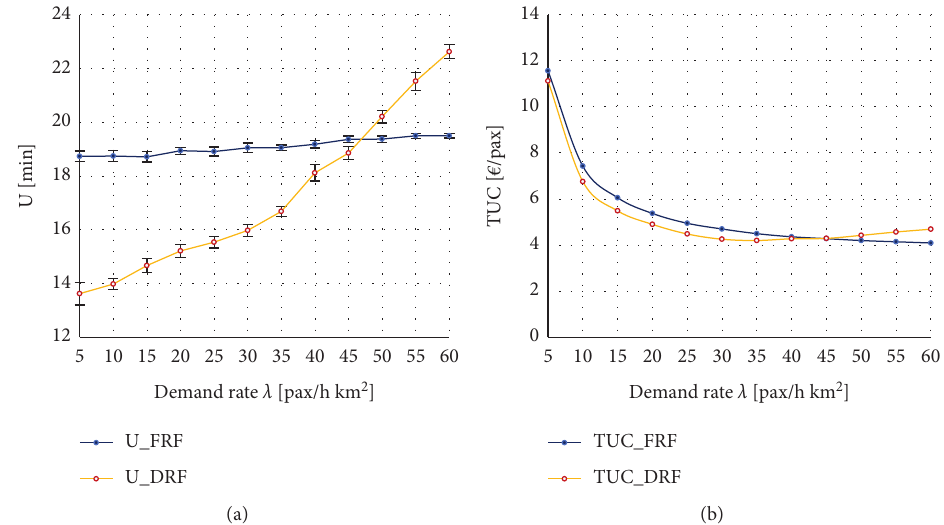
Figure 7: Performance of the Sc-base scenario in terms of user disutility (a) and transport unit cost (b) (bars in (a) showing confidence intervals).